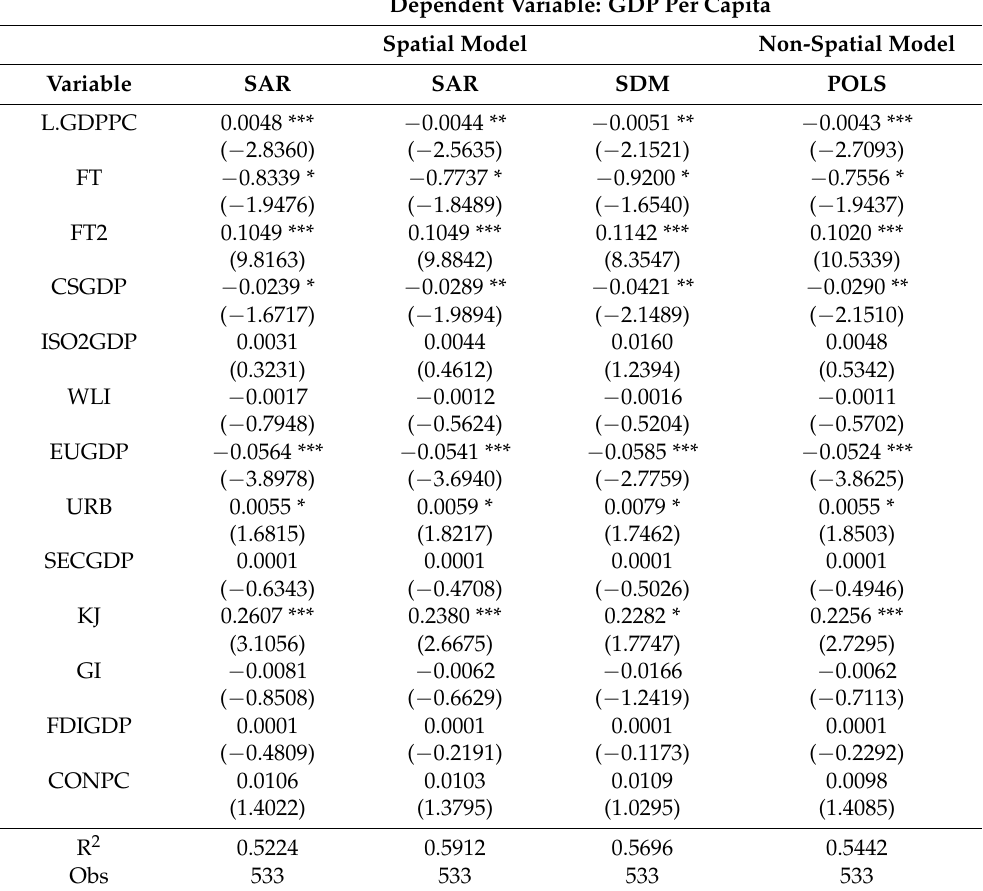
Table 5. Spatial econometric estimation